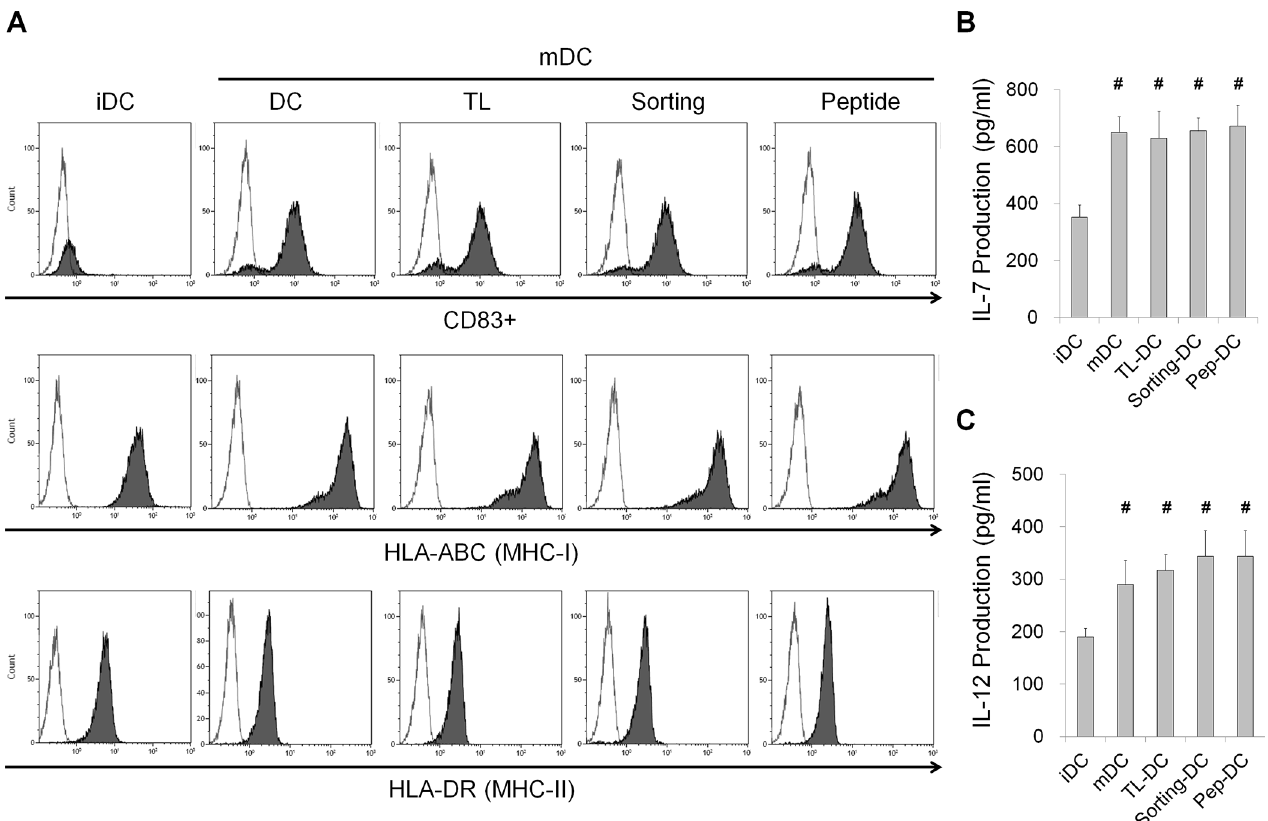
Fig 3. Analysis of DC surfacemarkersand the cytokine secretion assay. (A) The immunophenotype of DCs pulsedwith antigens. The mDC phenotypes were analyzedby flow cytometry using the indicatedantibodies (black areas) and isotype controls (white areas). (B and C) IL-7 (B) and IL-12 (C) levels in DC culture supernatants, as determined by ELISA. The data are expressed as the mean ± SD, and significantdifferences betweenthe treated groupswere detected using ANOVA followedby the Dunnett’s test. # p < 0.05comparedwith the iDCs.